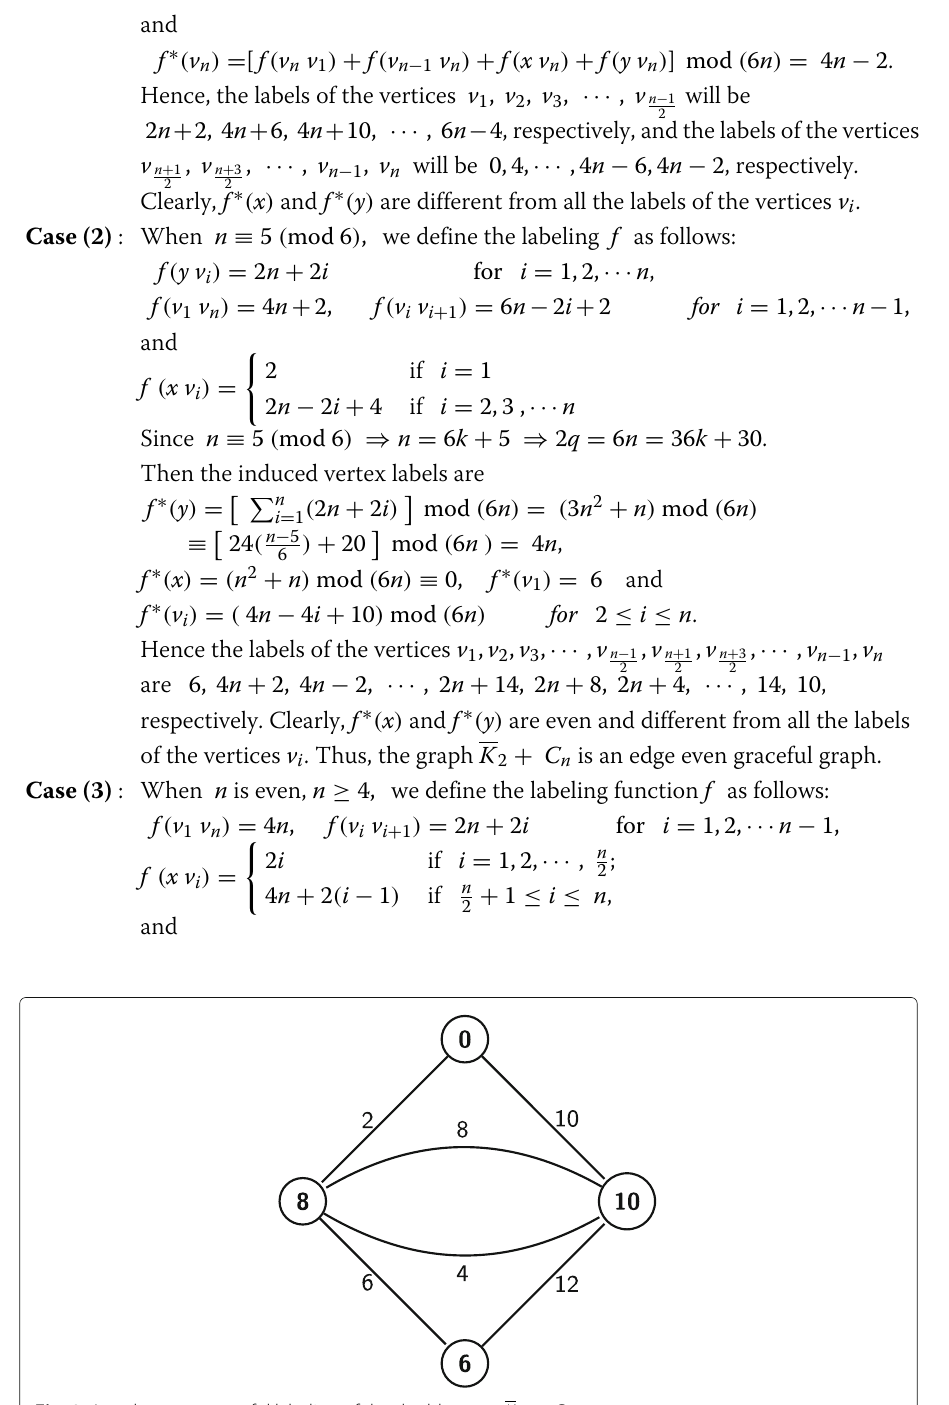
Fig. 8 An edge even graceful labeling of the double cone K 2 + C